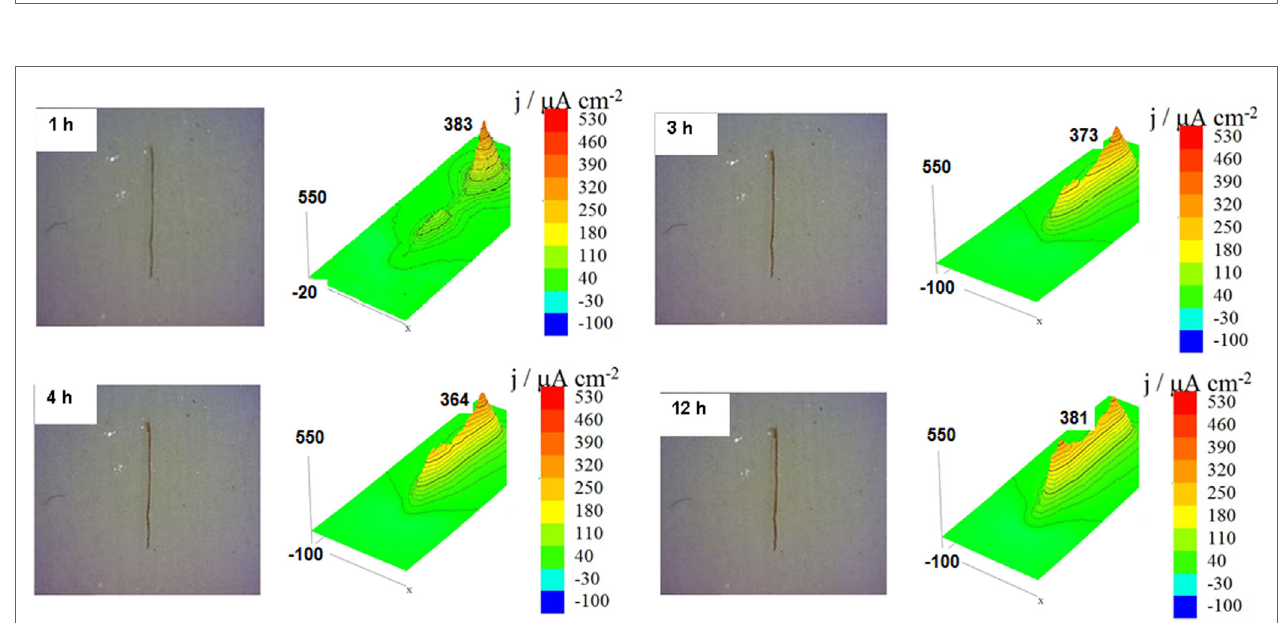
FigUre 9 | scanning vibrating electrode technique maps of the ionic currents measured above the surface of the carbon steel coated with alkyd primer without halloysite nanotubes and a provoked defect obtained after different immersion times in 0.01 mol/l nacl .